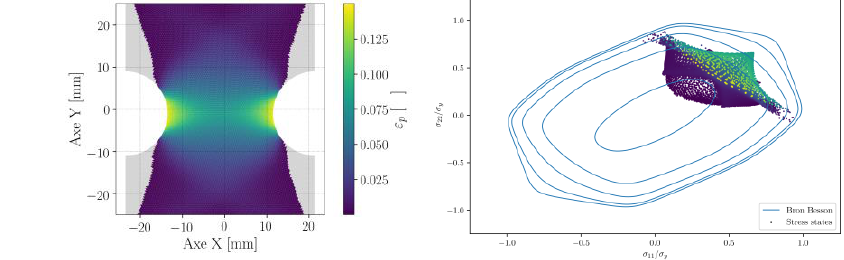
Fig. 5. Cumulated plastic strain field and stress states for a notched